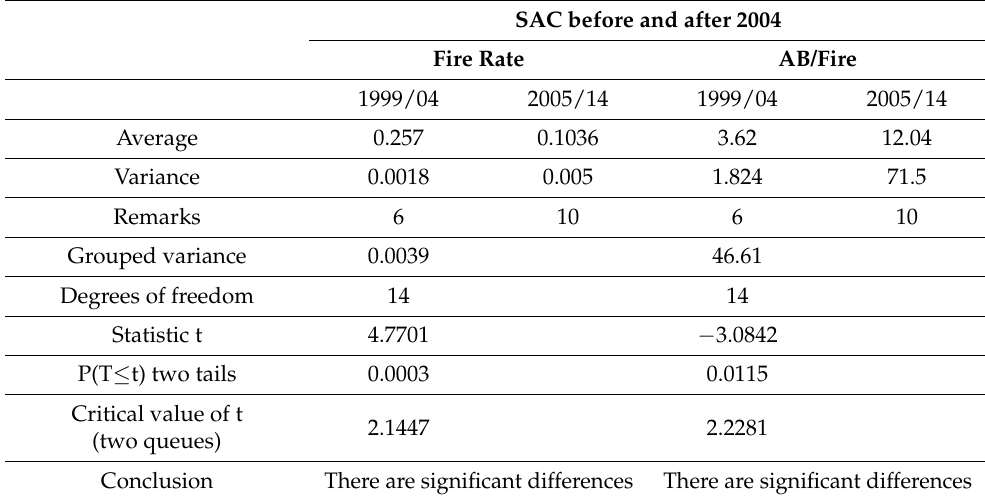
Table 4. Significant differences in the rate of forest fires and in the area burned by fire (BA/wildfire) in SACs, before and after 2004.